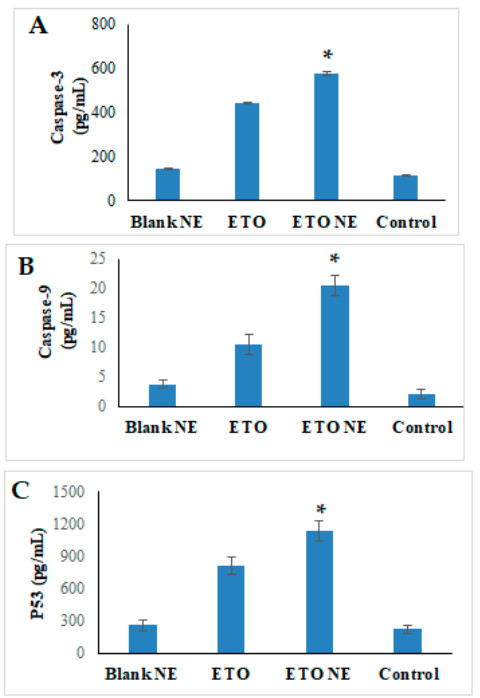
Figure 10. Effect of different formulation on ( A ) Caspase-3; ( B ) Caspase 9, and ( C ) p53. Data are expressed as (mean ± SD, n = 3) where, * denotes significant difference between ETO NE ( p < 0.05) vs. free ETO, blank NE and control group.